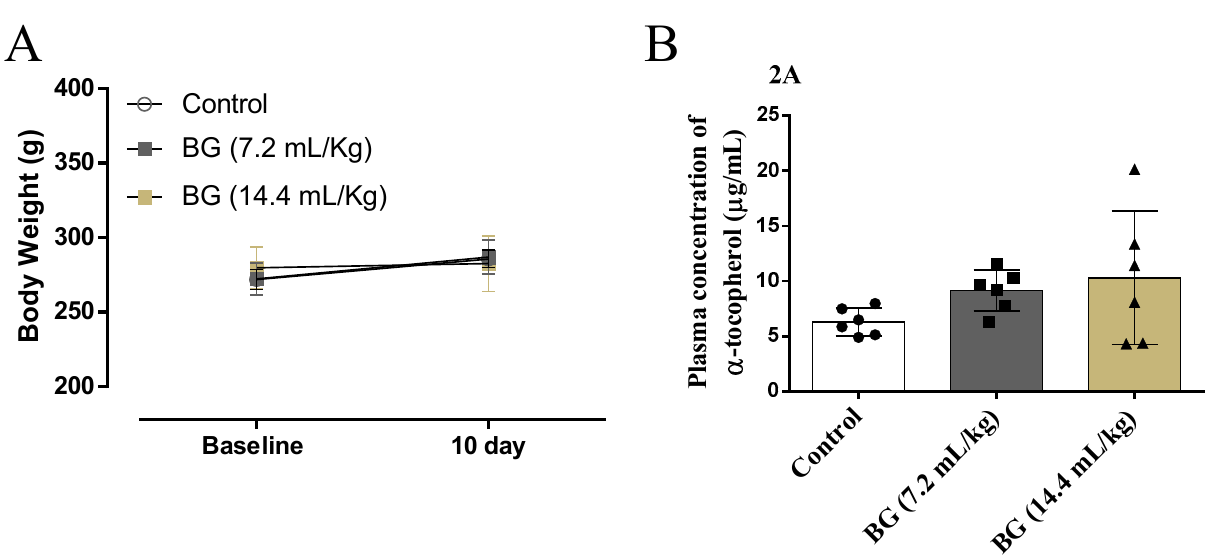
Figure 1. Assessment of body weight ( A ) and plasma concentration of α -tocopherol ( B ) in rats. Data are presented as mean ± standard deviation and analyzed by ANOVA one-way test with Tukey as a post-hoc test.